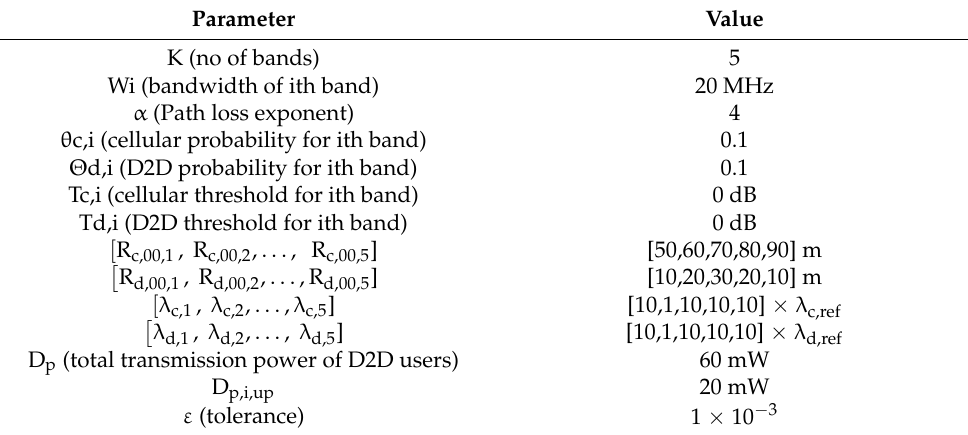
Table 1. Simulation parameters by using the derivative algorithm.